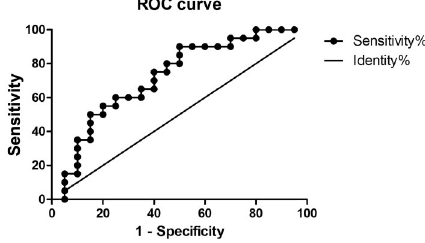
Figure 4. Receiver operating characteristic (ROC) curve demon- strating the predictive value of the relative expression of plasma miR-22 in post-stroke depression within 1 month.